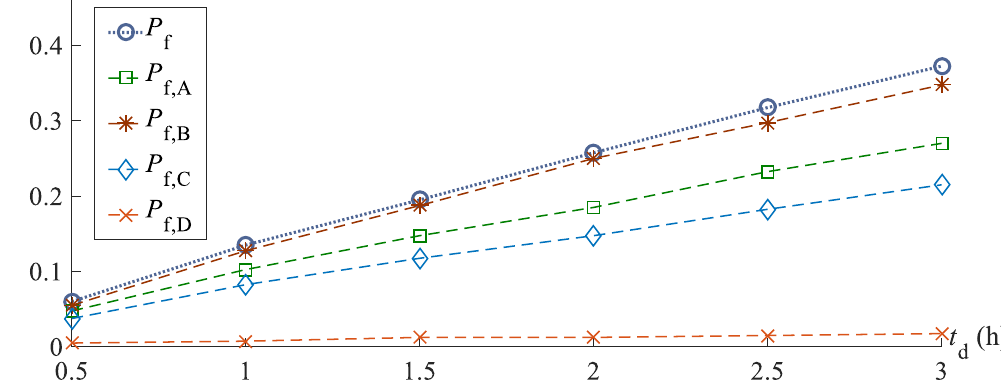
Figure 10. Component and system failure probabilities with different duration times.